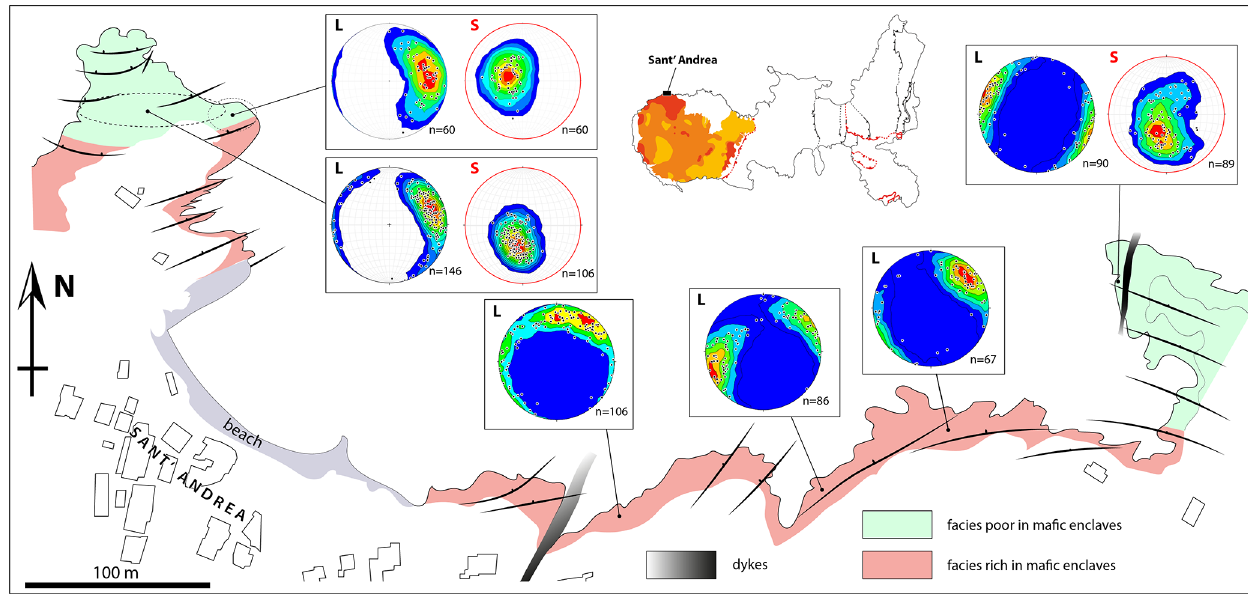
Figure 12. Detailed study of the orientation of K-feldspar megacrysts in the Sant-Andrea facies with foliation